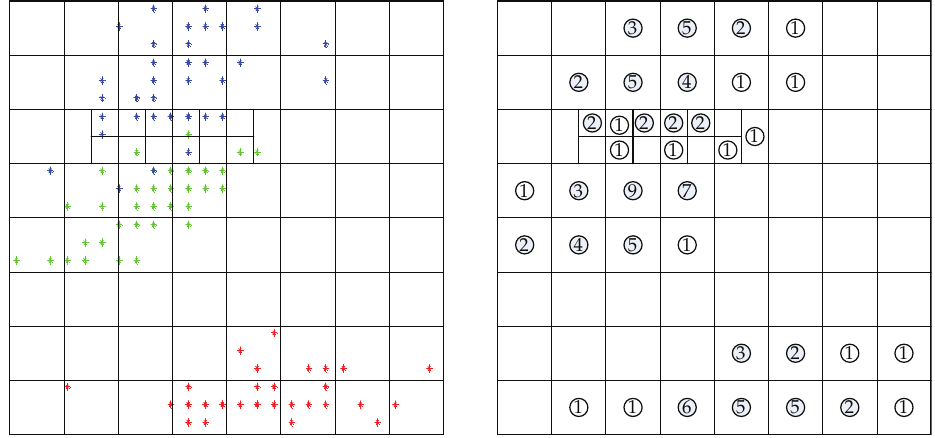
Figure 13: The Iris data figure for dimension x 2 − x 4 and with grids and candidate graph